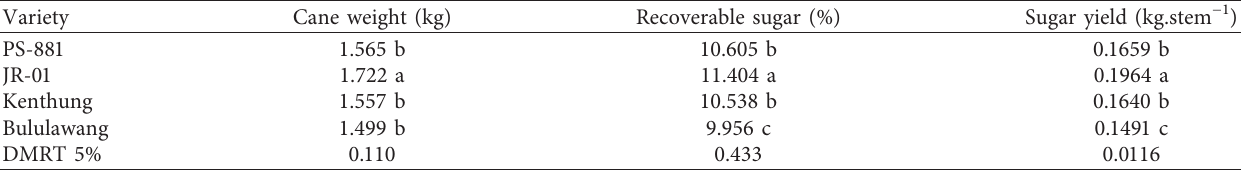
Table 1: Cane weight, recoverable sugar, and sugar yield of sugarcane